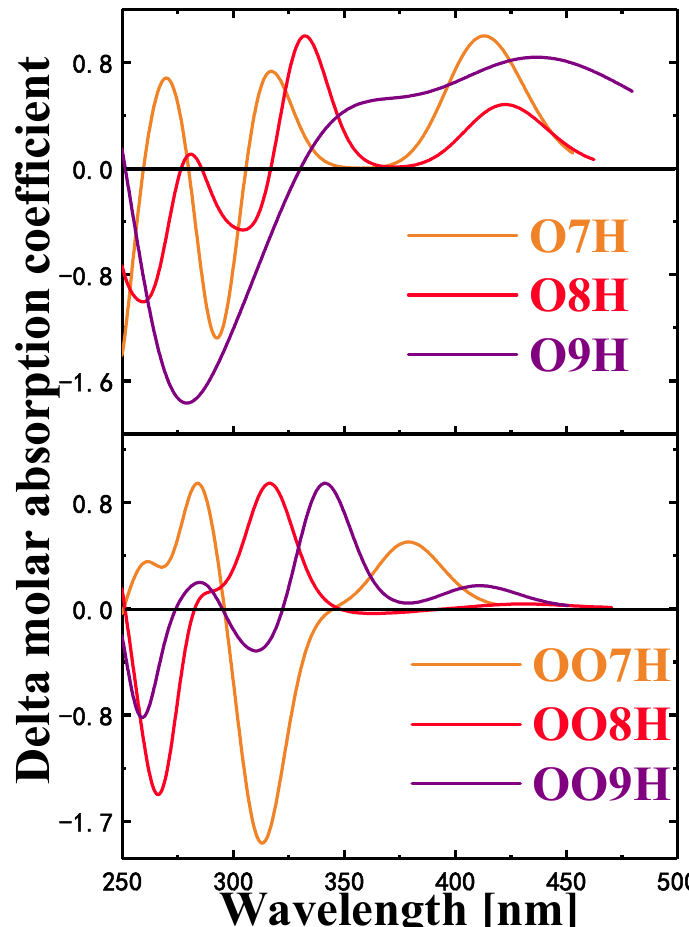
Figure 8. Electron circular dichroism combination diagram of O7H, O8H, and O9H (top), electron circular dichroism combination diagram of OO7H, OO8H, and OO9H (bottom).